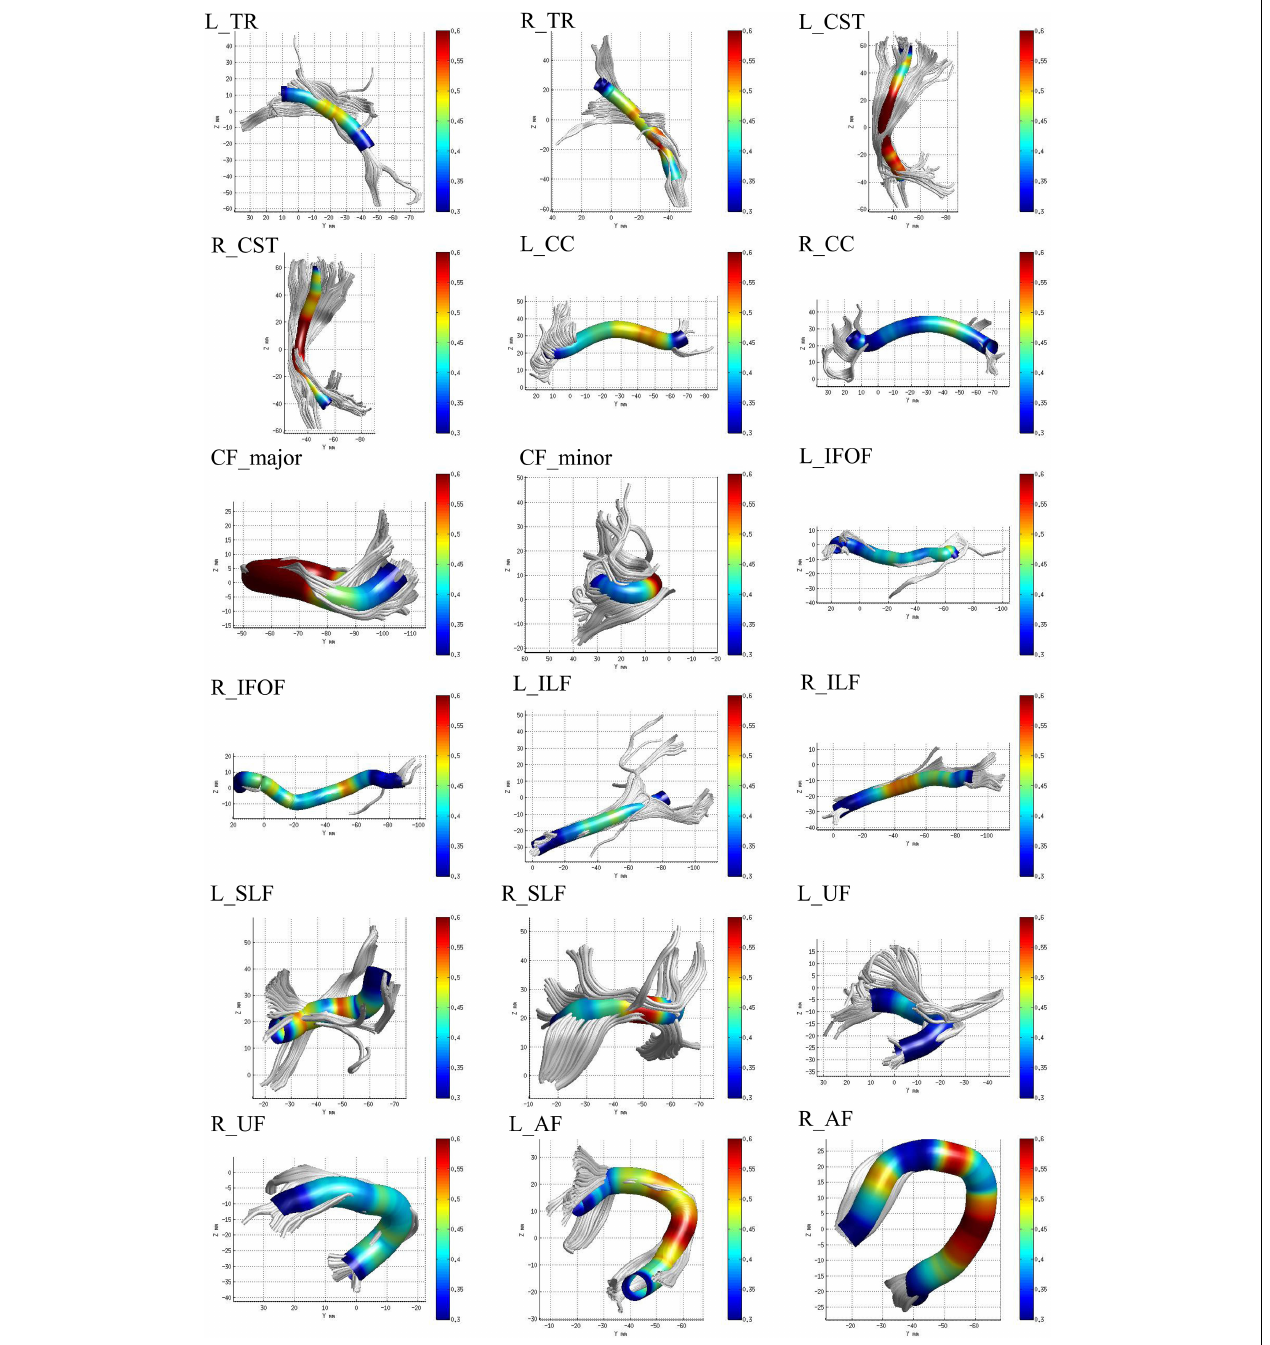
FIGURE 1 | The 18 identified white matter (WM) fiber tracts, such as bilateral thalamic radiation (TR), corticospinal tract (CST), cingulum cingulate (CC), inferior fronto-occipital fasciculus (IFOF), inferior longitudinal fasciculus (ILF), superior longitudinal fasciculus (SLF), uncinate fasciculus (UF), arcuate fasciculus (AF), callosum forceps major (CF_major), and minor (CF_minor) by automated fiber-tract quantification (AFQ).